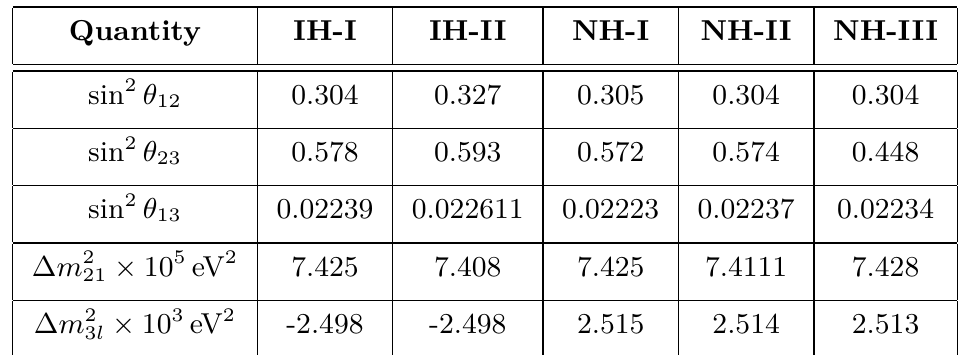
= ∆ m 2 > 0 for NH and ∆ m 2 = ∆ m 2 < 0 for 31 32 3 l 3 l